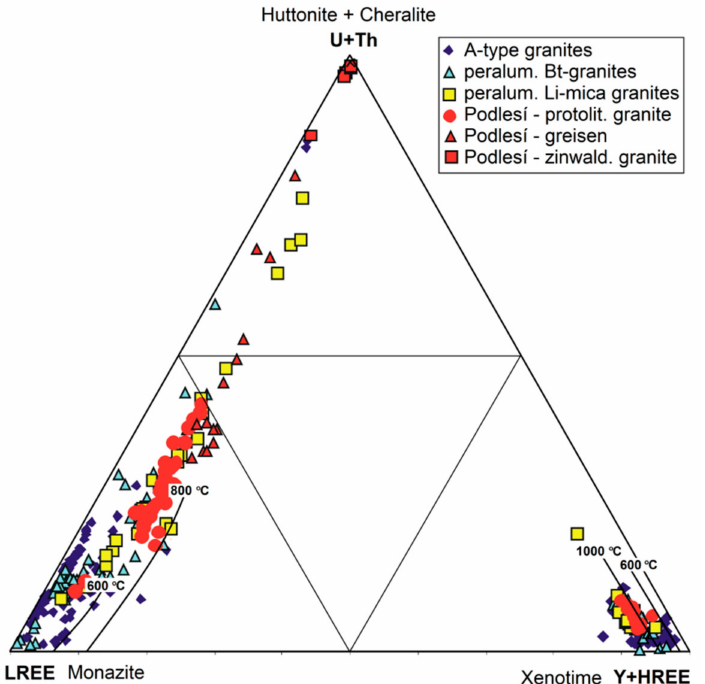
Figure 11. The monazite–xenotime–huttonite classification diagram. Temperatures of co-existing monazite–xenotime pairs in ◦ C according to